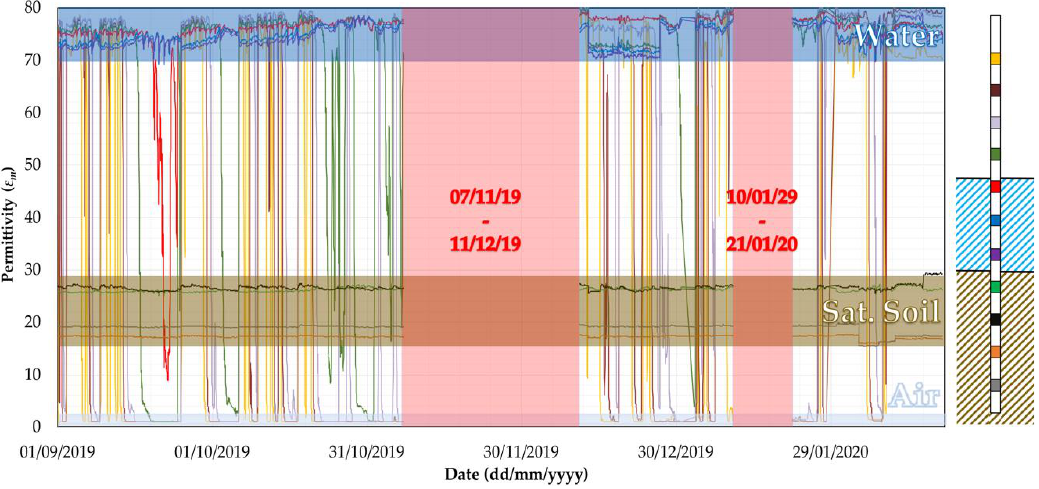
Figure 20. Readings of the 11 sensors installed into Probe 1.